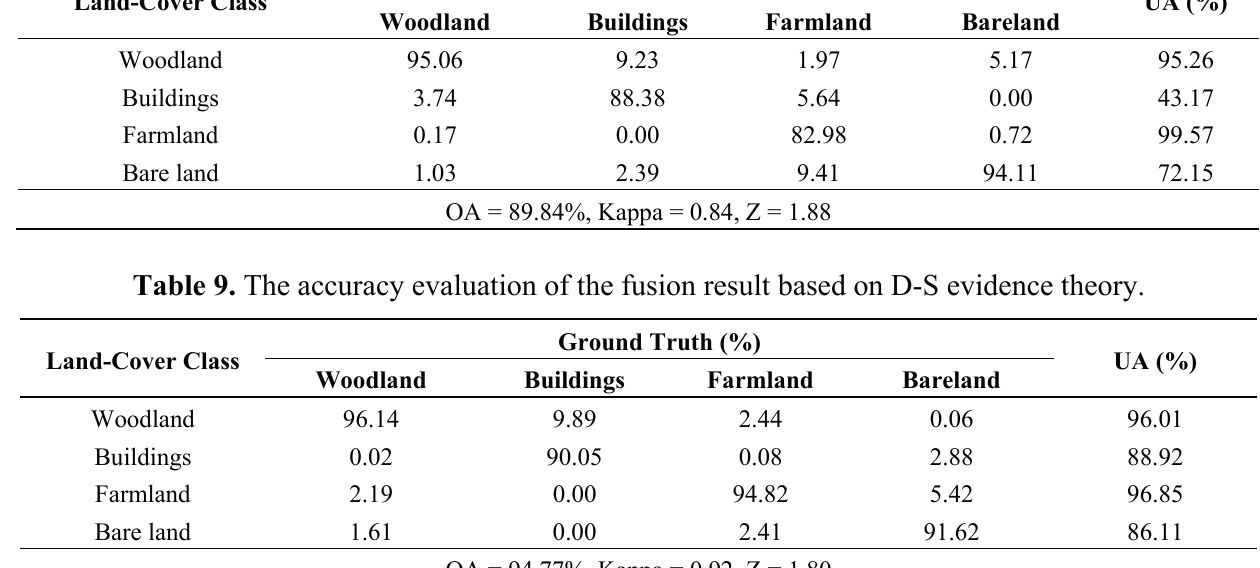
Table 8. The accuracy evaluation of the fusion result based on the K-means classifier. Land-Cover Class